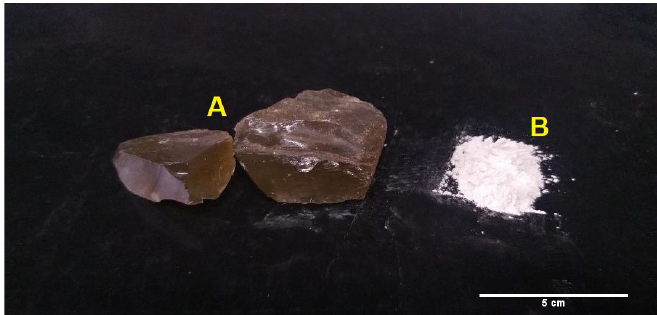
Figure 1. Macusanite pebbles (a) and their powder (b) form used in the